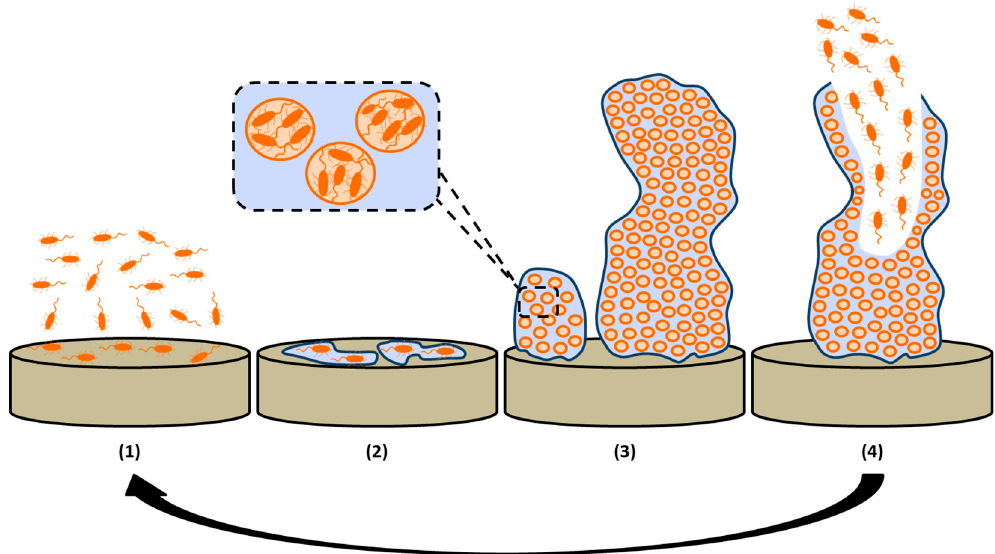
Figure 1. Schematic representation of the five main stages of biofilm formation. ( 1 ) Reversible attachment of bacteria cells, ( 2 ) irreversible attachment due to extracellular polymeric matrix (EPM) secretion, ( 3 ) development of biofilm structure, and ( 4 ) maturation and dispersion of biofilm.